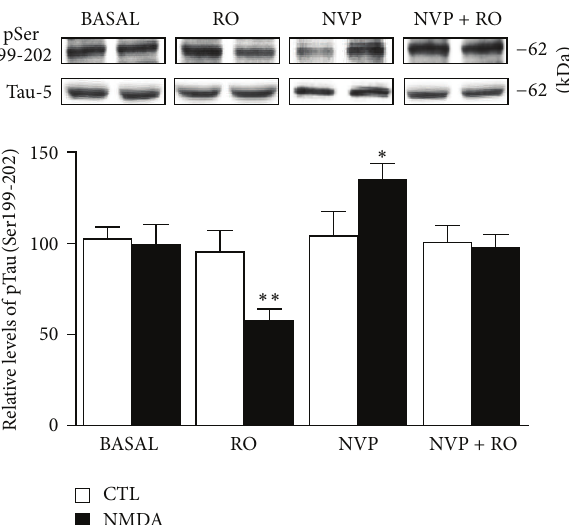
Figure 3: Tau phosphorylation at Ser262 and Ser404 residues is not altered by NMDA. Phosphorylation and protein levels were estimated by Western blotting of cell extracts (40 𝜇 g proteins) obtained from hippocampal slices treated with 10 𝜇 M NMDA for 1 hour. Phosphorylated Tau levels, expressed relative to total Tau (i.e., Tau-5) levels, were measured with antibodies raised against Tau phosphorylated at Ser199-202, Ser262, and Ser404. The data are expressed as percentages of control values and are means ± S.E.M. of 3 measurements per cell extract obtained from 6 different rats. Since these experiments were performed independently, we determined statistical significance by unpaired t -test. ∗∗ 𝑃 < 0.01 , NMDA- treated versus control.